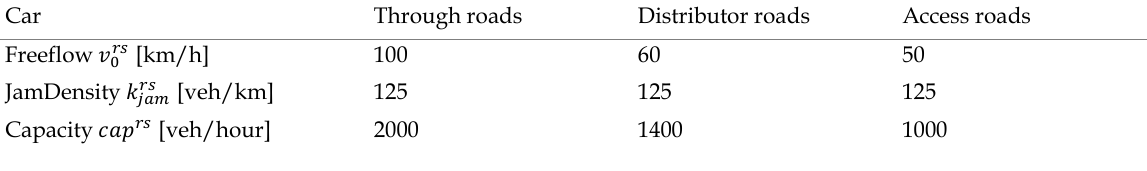
Parameters fundamental